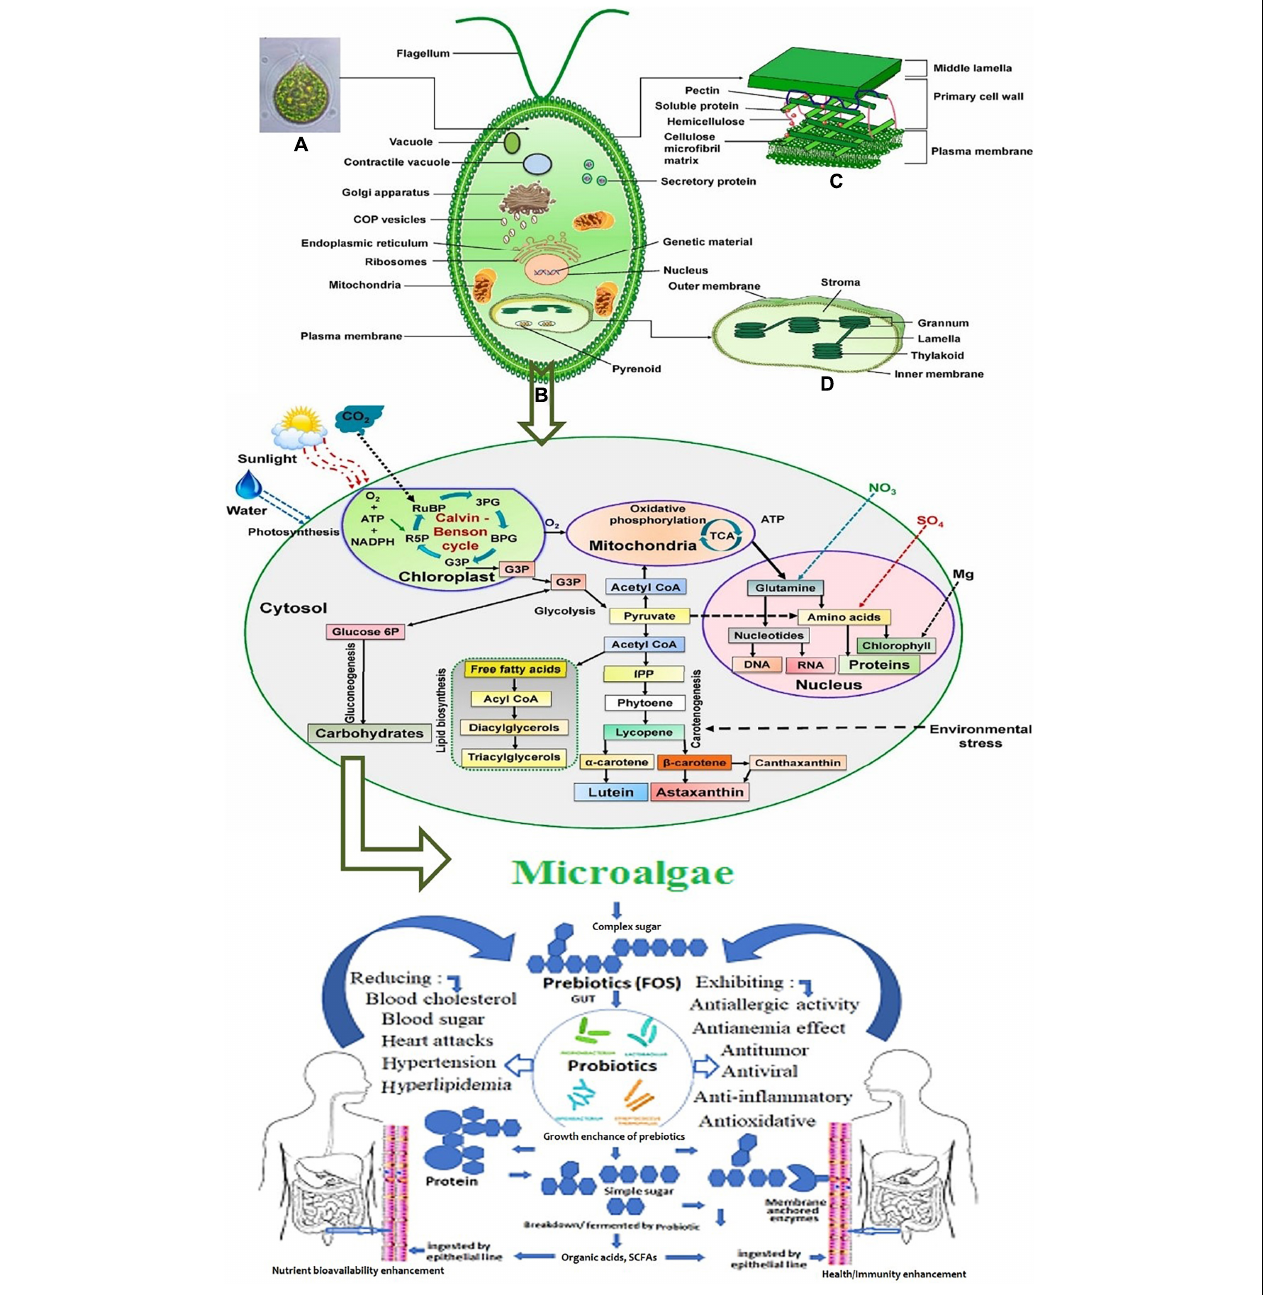
FIGURE 4 | Systematic representation of metabolic pathways in unicellular microalgae for the synthesis of prebiotics. (A) The metabolic process of biomolecules production. (B) The benefits of the produced prebiotics as functional compounds for human health (52). Figure 1 schematic illustration of eukaryotic microalgae: (A) microscopic image, (B) cellular component and organelles (C) cell wall structure, and (D) chloroplast structure. Adopted and modified from Mehariya, Goswami, Karthikeysan and Verma (52) (Copyright permission: 5179190025925).